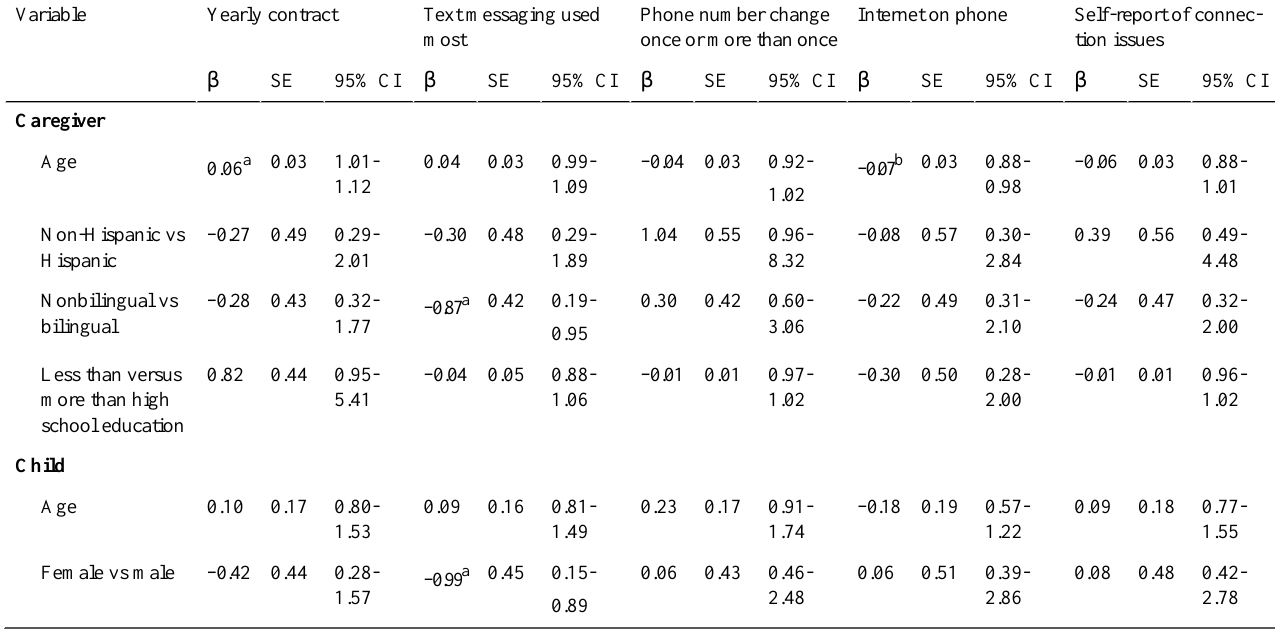
Table 4. Logistic regressions for relations between demographics and self-report of mobile phone use, characteristics, accessibility, and reliability of service. The first group of predictors listed served as the comparison group for the binary logistic regression analyses and were coded as 0, while the second group was coded as 1. All technology outcomes were coded dichotomously with no=0 and